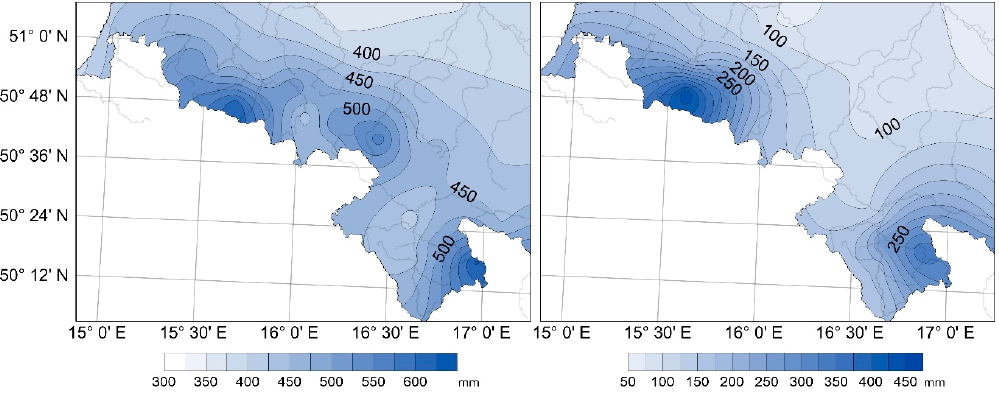
Figure A2. Mean summer half-year (May–October) precipitation (left) and runo ff (right)